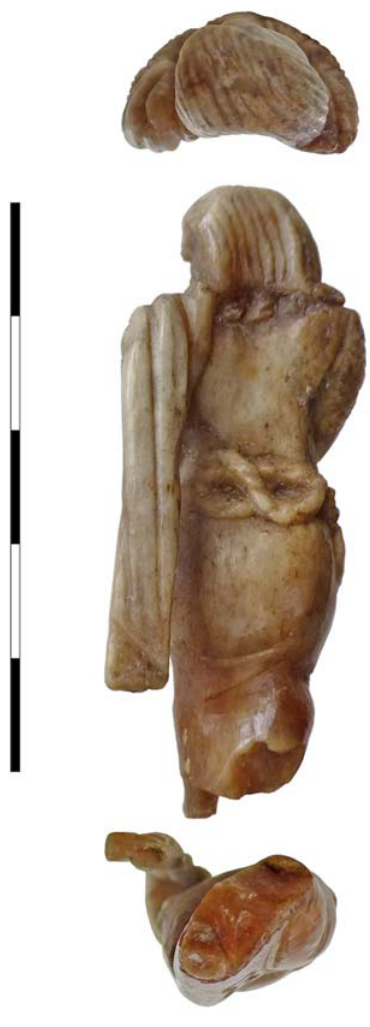
Figure 3: The fi gurine from I ž a - Leànyvàn. Posterior aspect and views from above ( up ) and below ( down ) . Scale subdivision, in centimetres ( Photo: Éva David )